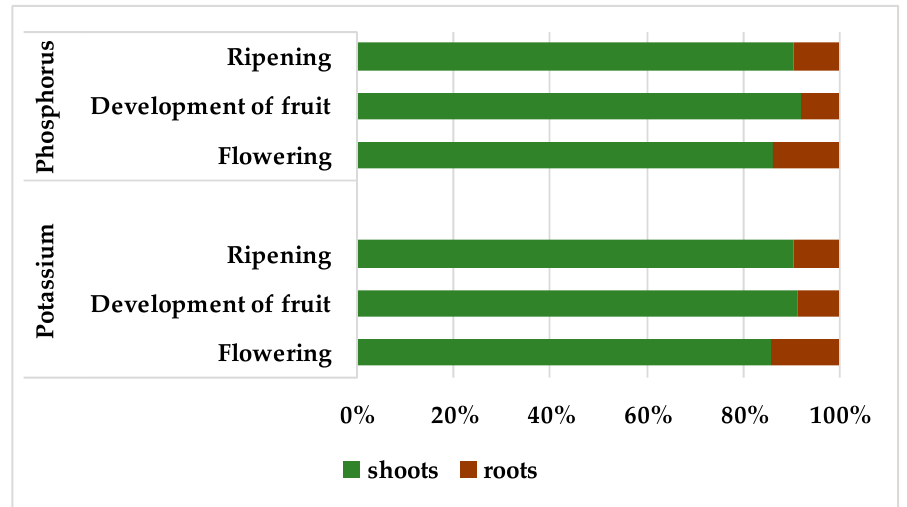
Figure 1. Participation of shoots and roots in the total P and K accumulation in rapeseed in generative development stages (%). Table 3. Accumulation of P. Significance of experimental factors and their interaction, * P ≤ 0.05; ** P ≤ 0.01, mean 2011–2013.